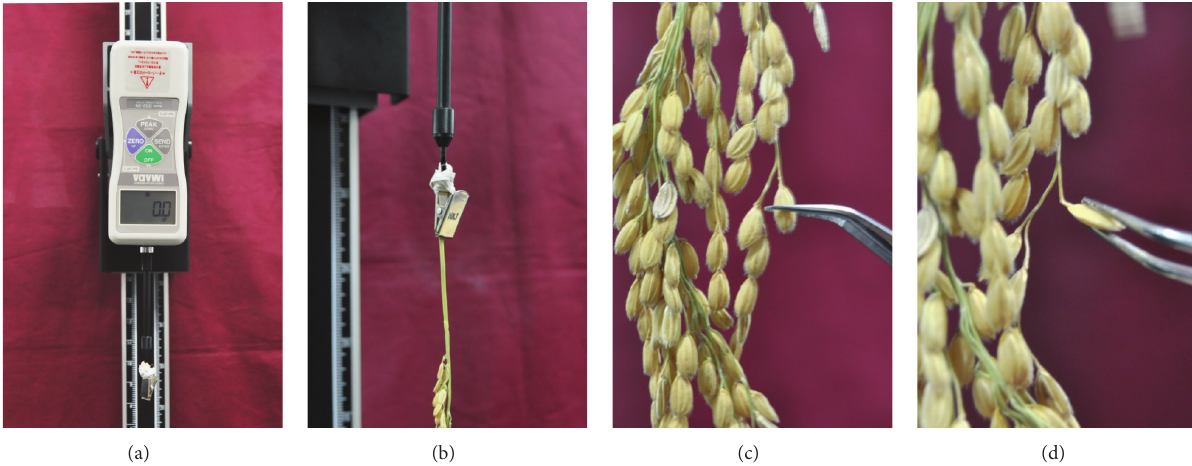
Figure 1: Measurement of seed shattering degree using a force gauge. (a) The device used to measure shattering degree was fixed to a stand reversely. (b) A holder was used to link tightly with a panicle stem. (c, d) The breaking tensile strength (BTS) was measured by bending and pulling a spikelet.